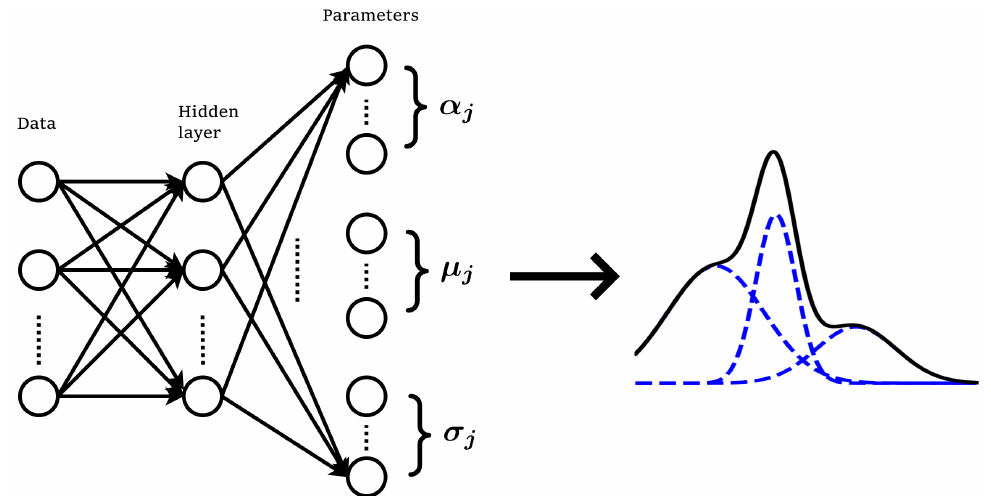
Figure 3. Schematic representation of a Mixture Density Network: parameters for a multimodal Gaussian distribution are obtained using a Neural